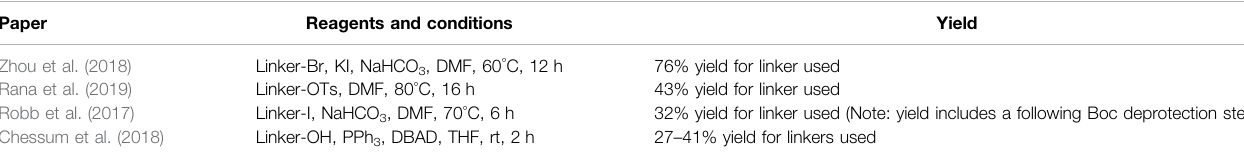
TABLE 3 | Reagents, conditions, and yields for the conversion of 45 to 46 ( Scheme 10 , step b).